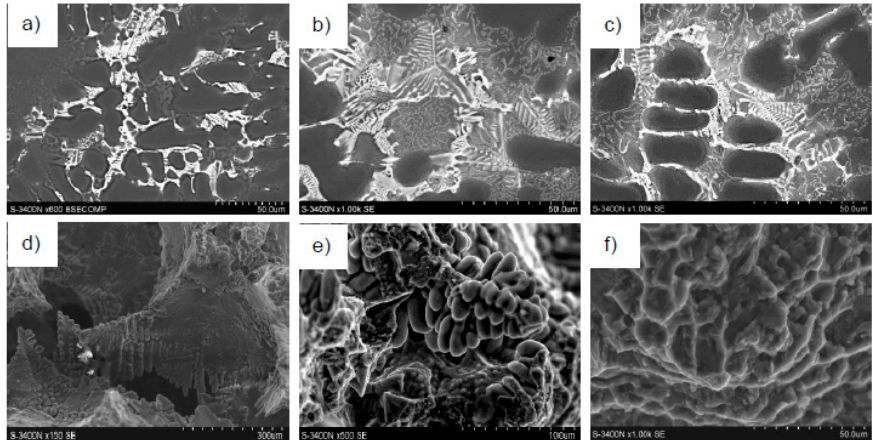
Figure 4. Microstructure of alloy AlSi10Mg0.5Mn0.5: ( a , d ) in initial condition (with various magnifications); ( b , e ) with addition of powder-1; ( c , f ) with addition of powder-2; ( a , b , c —light microscope, d , e , f —scanning microscope).